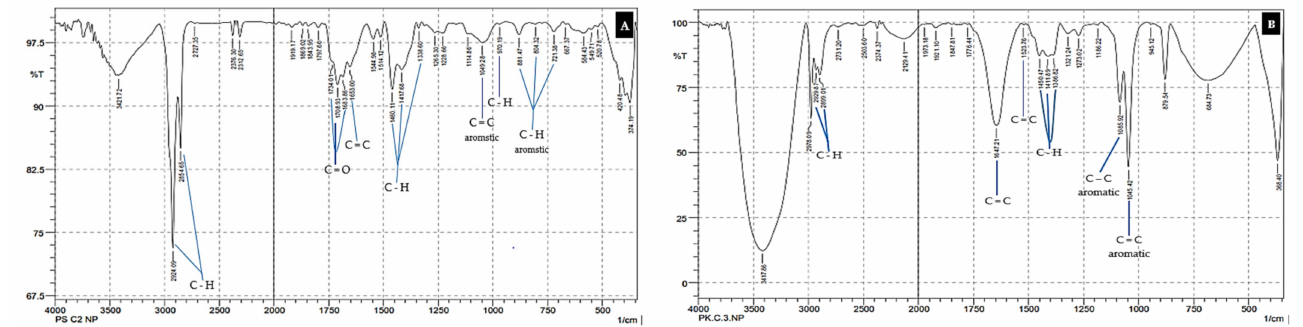
Figure 4. Identification of the type of MP pollutant in the sample based on the FTIR chromatogram. ( A ) Sediment samples; ( B ) sponge